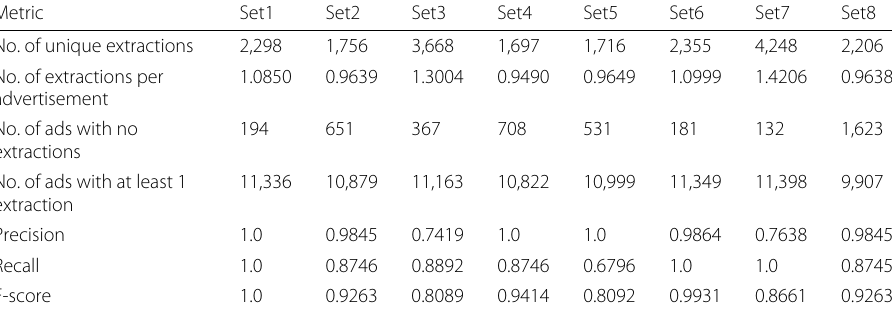
Table 5 Dataset characteristics for phone extractions